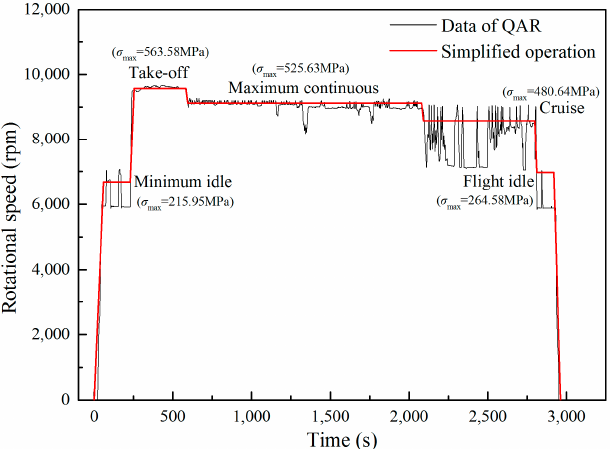
Figure 8. Typical load cases in a whole flight cycle.